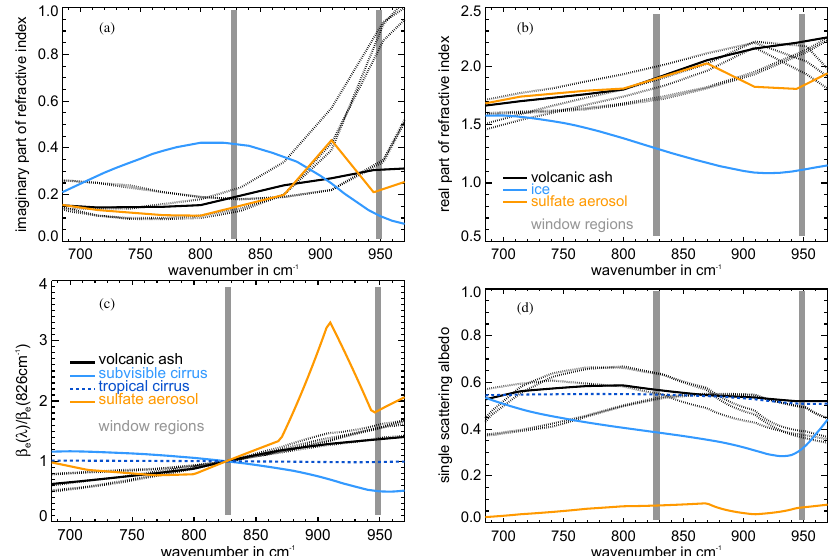
Figure 1. (a) , (b) Complex refractive index spectra for volcanic ash (black solid line, Volz, 1973), volcanic ash compounds (black dotted lines for andesite, basalt, basaltic glass, and obsidian, Pollack et al., 1973), ice, and sulfate aerosol in MIPAS band A. (c) Extinction coefficient and (d) single scattering albedo spectra for volcanic ash, volcanic ash compounds, ice, and sulfate aerosol. The corresponding particle size distributions are presented in Table 1. The extinction coefficient is normalised to 1 at 826cm − 1 . The grey regions denote atmospheric windows used for volcanic ash detection.